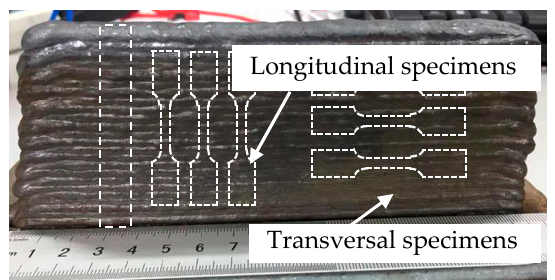
Figure 2. Schematic diagram for sampling location.